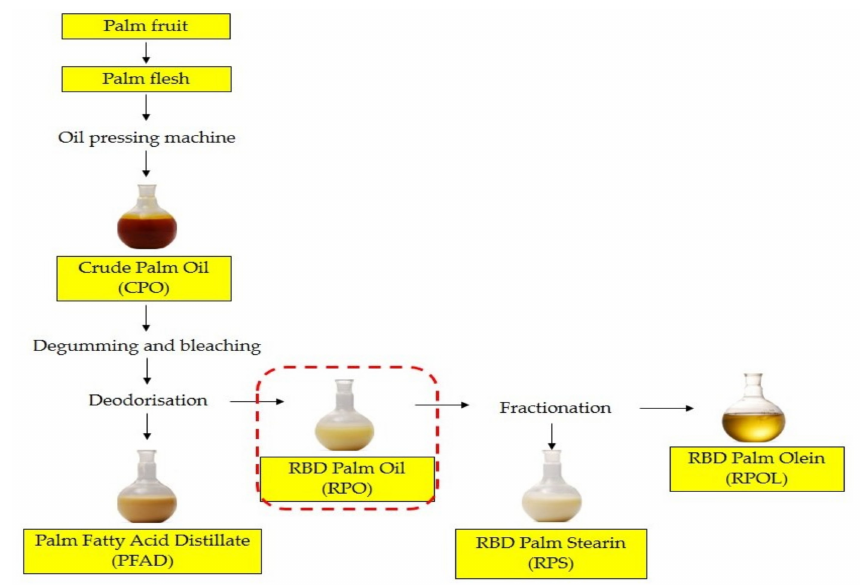
Figure 1. The refinery palm oil process. Refined palm oil (RPO), seen within the red dashed box, was used as feedstock. RBD is an abbreviation of refined, bleached, and